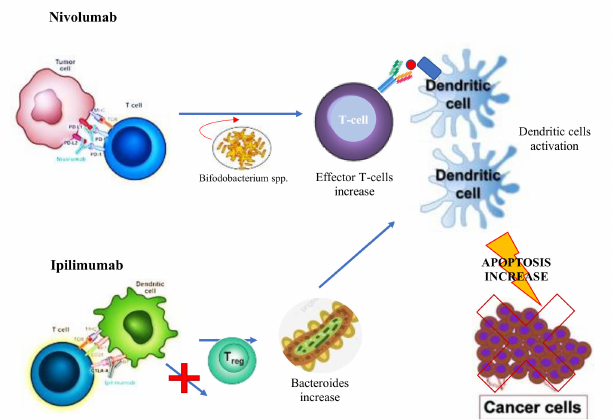
Figure 2. Anti-CTLA-4 immunotherapy (Ipilimumab) and Anti- PD-1 (Nivolumab) cause cancer cell apoptosis through their direct Tregs paralyzation, thus activating e ff ector T cells and dendritic cells, also supported by the induced increase of certain bacterial species, such as Bacteroidales